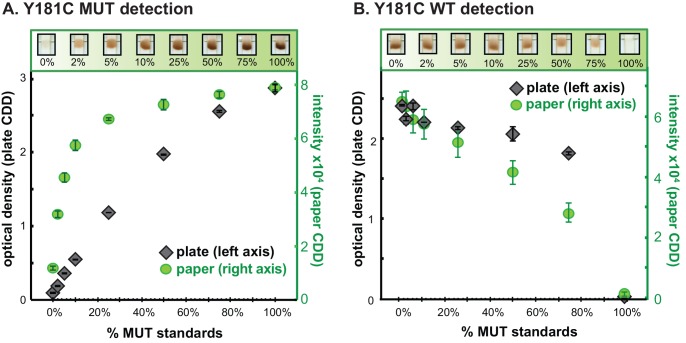
Comparison of paper Capture, Denaturation, and Detection (CDD) and plate CDD for analysis of a plasmid standard mixture series for mutation Y181C.(A) Scanned images of paper CDD MUT (left) and WT (right) detection (B) Mutant (MUT) detection (C) wild-type (WT) detection. Left axes: Specimen optical density (OD) minus negative control OD analyzed in duplicate by plate CDD (mean ± SE). Right axes: Specimen capture intensity minus background intensity analyzed in triplicate by paper CDD (mean ± SE). The ratio of mean signal intensities for 2% MUT and 0% MUT was 2.00 for plate CDD and 2.74 for paper CDD.